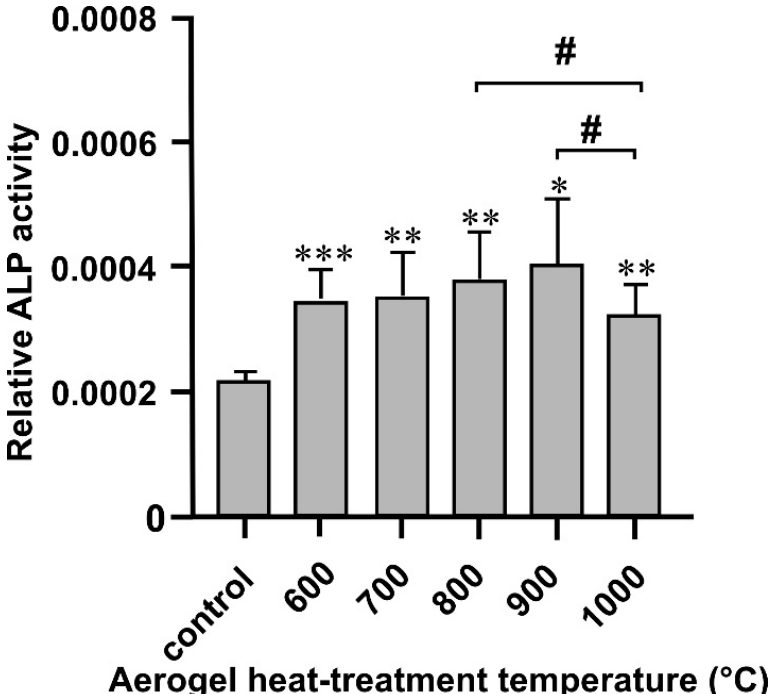
Figure 9. The effects of the differently heat-treated aerogel composites on the ALP activity of MG63 cells cultured for 14 days. Values are expressed as sample means; error bars represent the estimates of standard deviations calculated from three parallel measurements compared to the control (* p < 0.05, ** p < 0.01, *** p < 0.001); # p < 0.05 between the different temperatures.